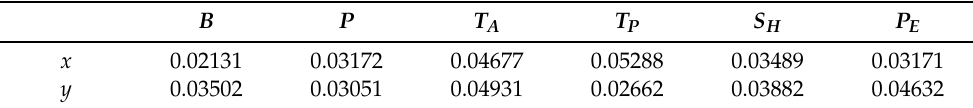
Figure 11. The distortion error before correction and the predicted distortion flow for different distortions: ( a ) B (barrel), ( b ) P (pincushion), ( c ) T A (tangential), ( d ) T p (thin prism), ( e ) S H (shear) and ( f ) P E (perspective). Table 5. Average position error of different